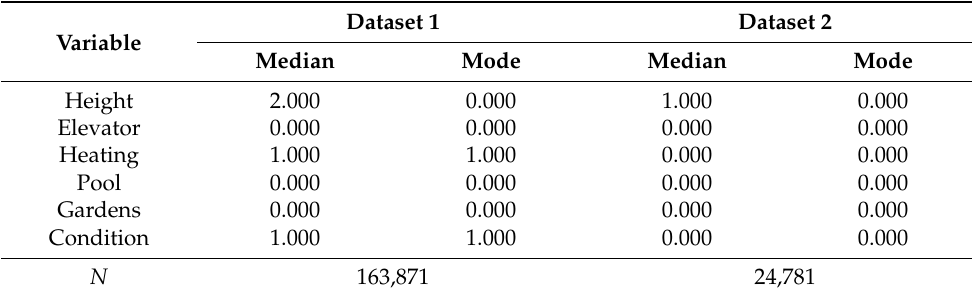
Table 3. Descriptive statistics of the qualitative and dichotomous